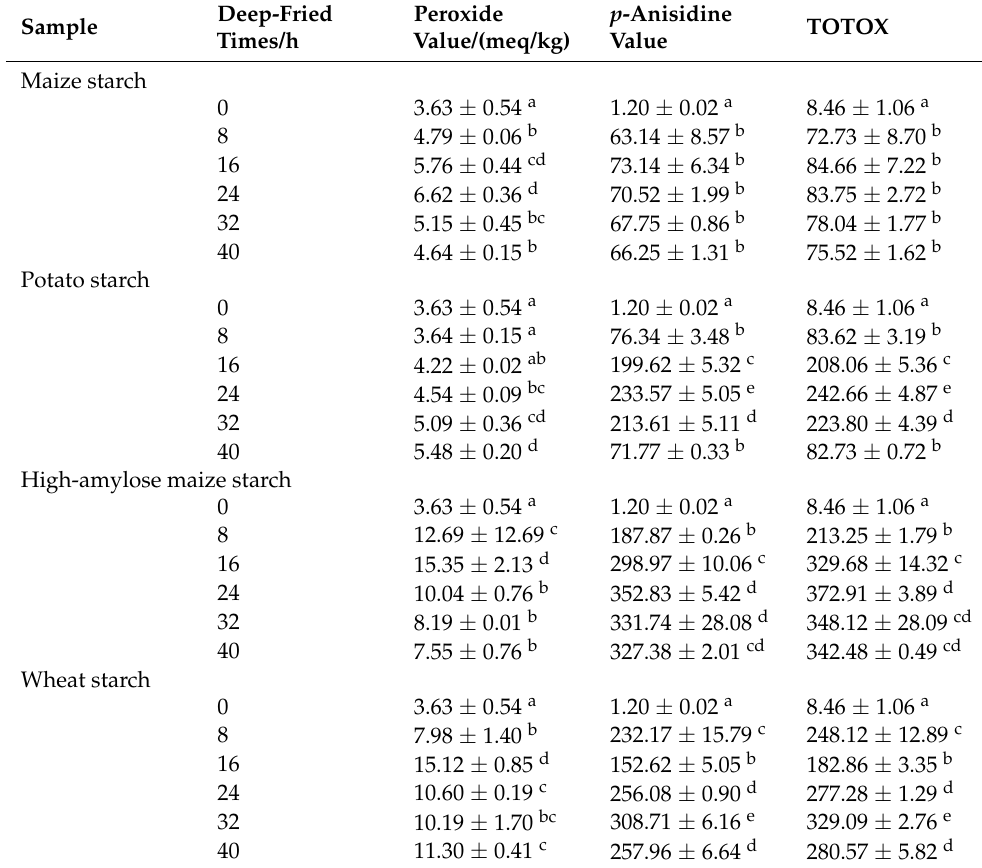
Table 3. Analysis of oxidative stability of deep-frying oil.